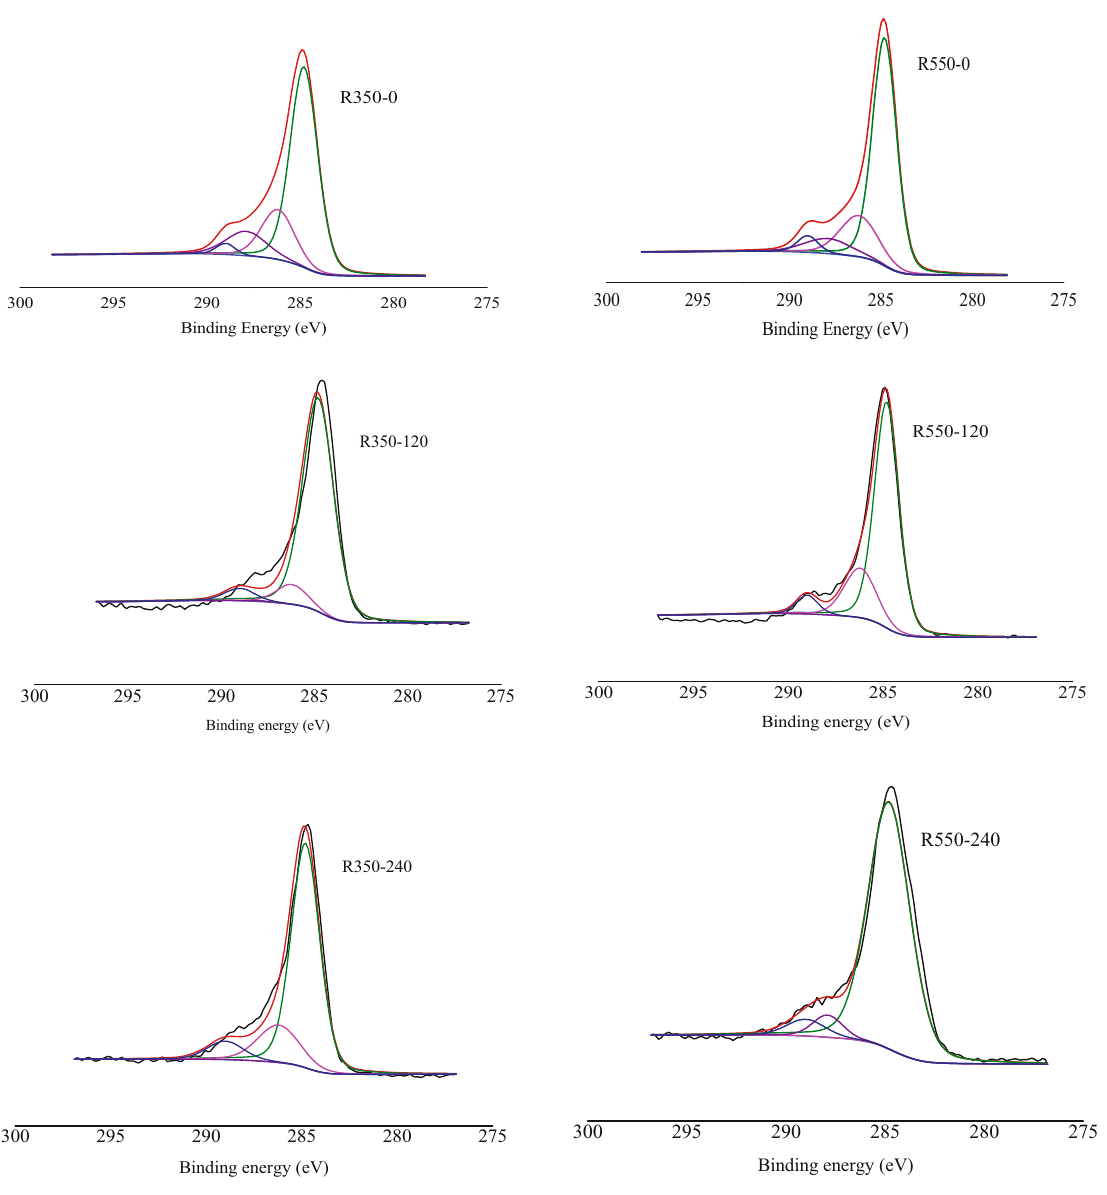
Figure 3: XPS C 1s scan and peak fi tting for the R350 and R550 biochar samples during ageing in soil for 0, 120 and 240